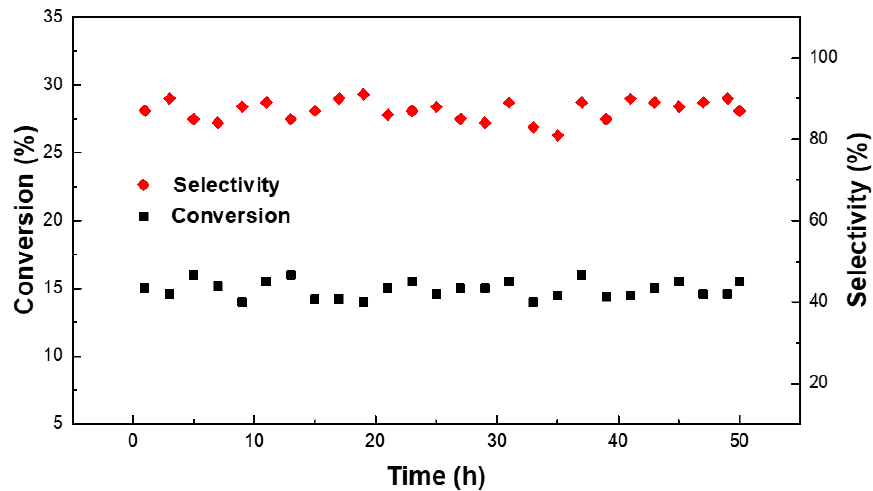
Figure 9. Conversion of methanol and selectivity of DMM using V-Ti-HMS(30) in the methanol oxidation. Table 2. Performance of catalysts in the methanol oxidation reaction.